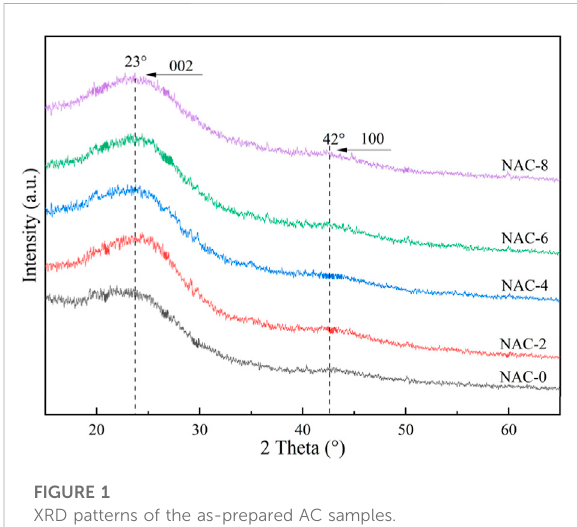
FIGURE 1 XRD patterns of the as-prepared AC